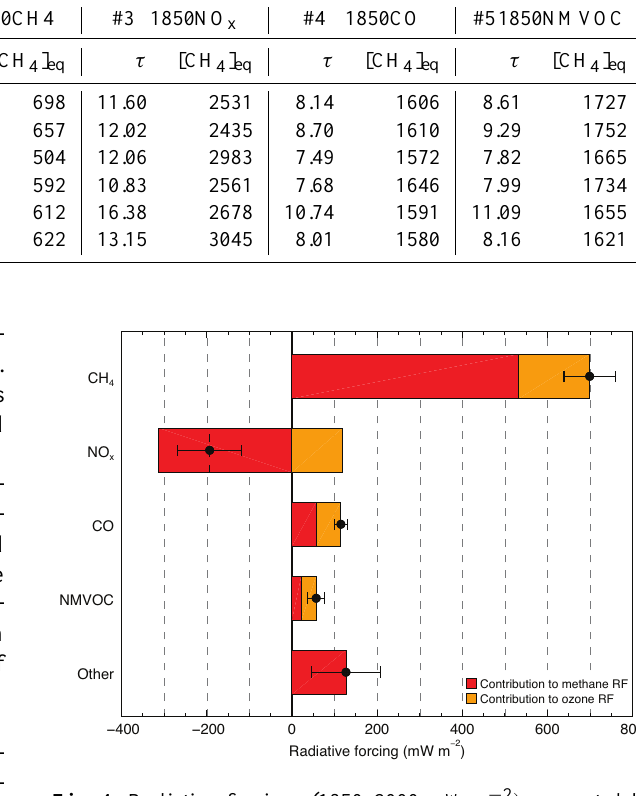
Fig. 4. Radiative forcings (1850–2000,mWm − 2 ) generated by emissions of methane, NO x , CO, NMVOC, and the interactions be- tween these emissions (“Other”), split into their methane and ozone components. Dots are the net RF for each emission, with error bars estimated from the individual uncertainties listed in Tables 10 and 11.